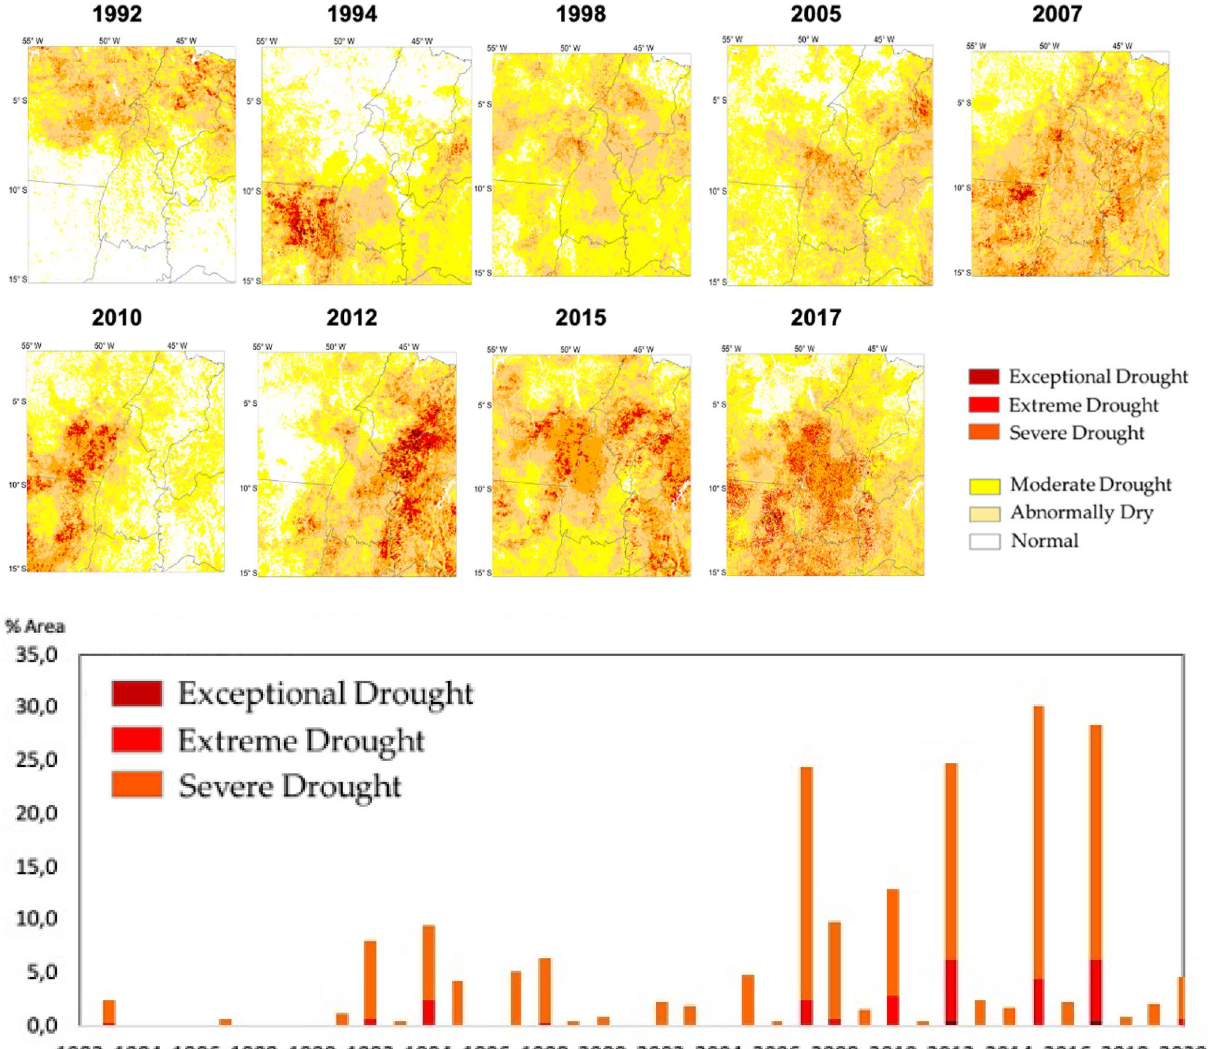
Figure 3. Evolution of drought area in the MATOPIBA regions. Time series of percentage of area affected by severe to exceptional drought from 1982 to 2020 using Integrated Drought Index (IDI). Spatial patterns of IDI are also shown for exceptional years. Maps in the upper level produced by using ArcMap 10.6; www. esri. com/ en- us/ home (https:// www. esri. com/ en- us/ The exposure of affected areas to drought and its intensity can be assessed by the Integrated Drought Index (IDI), which combines the lack of precipitation and the vegetation response to water stress (Fig. 3): 1992, 1994, 1998, 2005, 2007, 2010, 2012, 2015 and 2017 were years when the area affected by severe to exceptional drought increased. Some of these years are recognized as strong El Niño years (1998, 2015) or having an anomalously warm Tropical North Atlantic (2005, 2010). Note that the area impacted by drought was at least as large as that in other years (e.g., 2007, 2012, 2017). This suggests that the impacts of the exceptional droughts of 2005 and 2010 may be surpassed by the exacerbated dry condition already established in the region in recent years, and not necessarily attributable to El Niño or warm Tropical North Atlantic conditions. Consequently, during the period 2007–2020, more than 25% of the MATOPIBA region was affected by severe to exceptional drought in four years (2007, 2012, 2015 and 2017) (Fig. 3). This trend towards an increase in drought frequency also occurs in a scenario of land cover changes in the EAC, characterized by conversions to pastures and croplands since the mid 1980s 61 . Global land cover satellite MODIS MCD12C1 products from 2001 to 2019 show that area of forest has diminished gradually at a rate of 2.8% (p < 0.01) per decade in the last 20 years (Extended Data Figs. 5, 6). In contrast, the combination of savanna, grasslands, and croplands increased significantly. Between 2002 and 2011, deforestation rates in the Cerrado (1% per year) were 2.5 times higher than in the Amazon basin (EMBRAPA-www. embra pa. br). This overall drying and warming trend over MATOPIBA may depend on land cover (Extended Data Fig. 7), with trends in air temperature and evaporation over forests (EBF class) resembling trends over areas converted from forest to savannah and grasslands (Extended Data Fig. 8). The warming trend, however, is not necessarily in line with